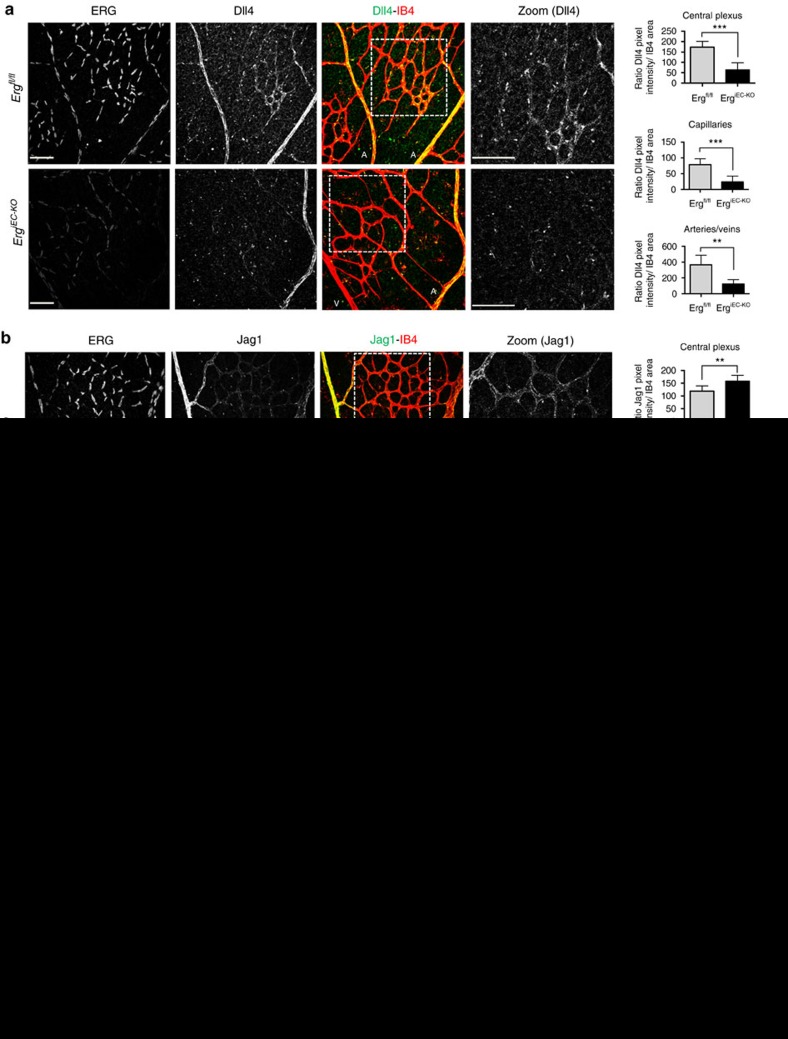
ERG controls Dll4 and Jag1 expression in the plexus of the mouse retina.Representative images and quantification of Dll4 and Jag1 (green) staining of postnatal day 6 retinal vessels in the (a and b) stable plexus and (c and d) angiogenic front from Ergfl/fl and ErgiEC-KO mice. Retinas are co-stained for isolectin B4 (IB4, red) and ERG (white, presented as a separate channel). Quantification represents the ratio between the sum of pixel intensity and isolectin B4 area (n=4 fields per mouse, n=4 mice per genotype). Scale bar, 70 μm. Arteries (A) and veins (V) are indicated. Arrowheads highlight tip cells at the angiogenic front. All graphical data are mean±s.e.m., *P<0.05, **P<0.01, ***P<0.001, Student's t-test.